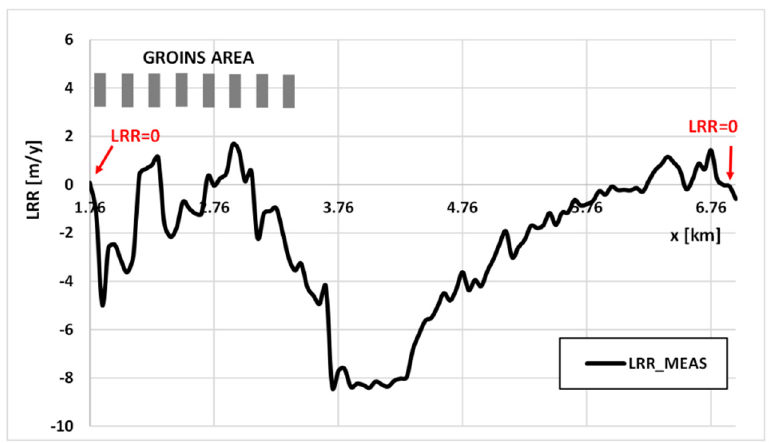
Figure 3. Linear regression rate ( LRR ) function of the Trigno river mouth area during the period 2004 - 2016. The vertical dashes indicate groins; red arrows indicate the LRR = 0 boundary condition.